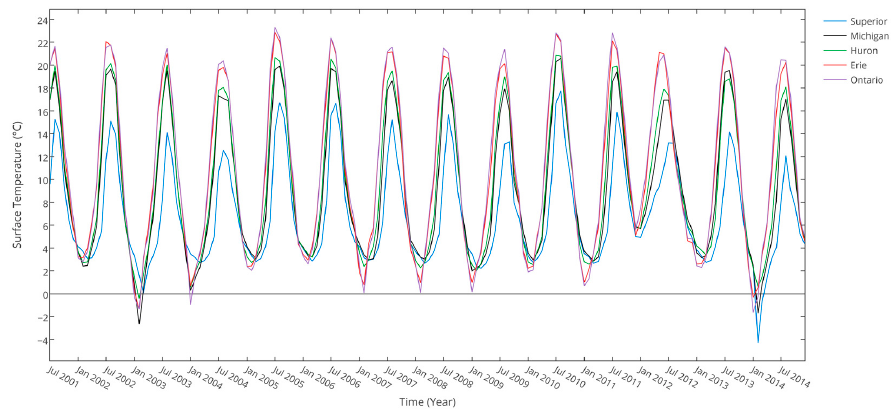
Figure 5. Lake-wide time series evaluated from GLST monthly means of daily averages during July 2001 to December 2014 (°C).